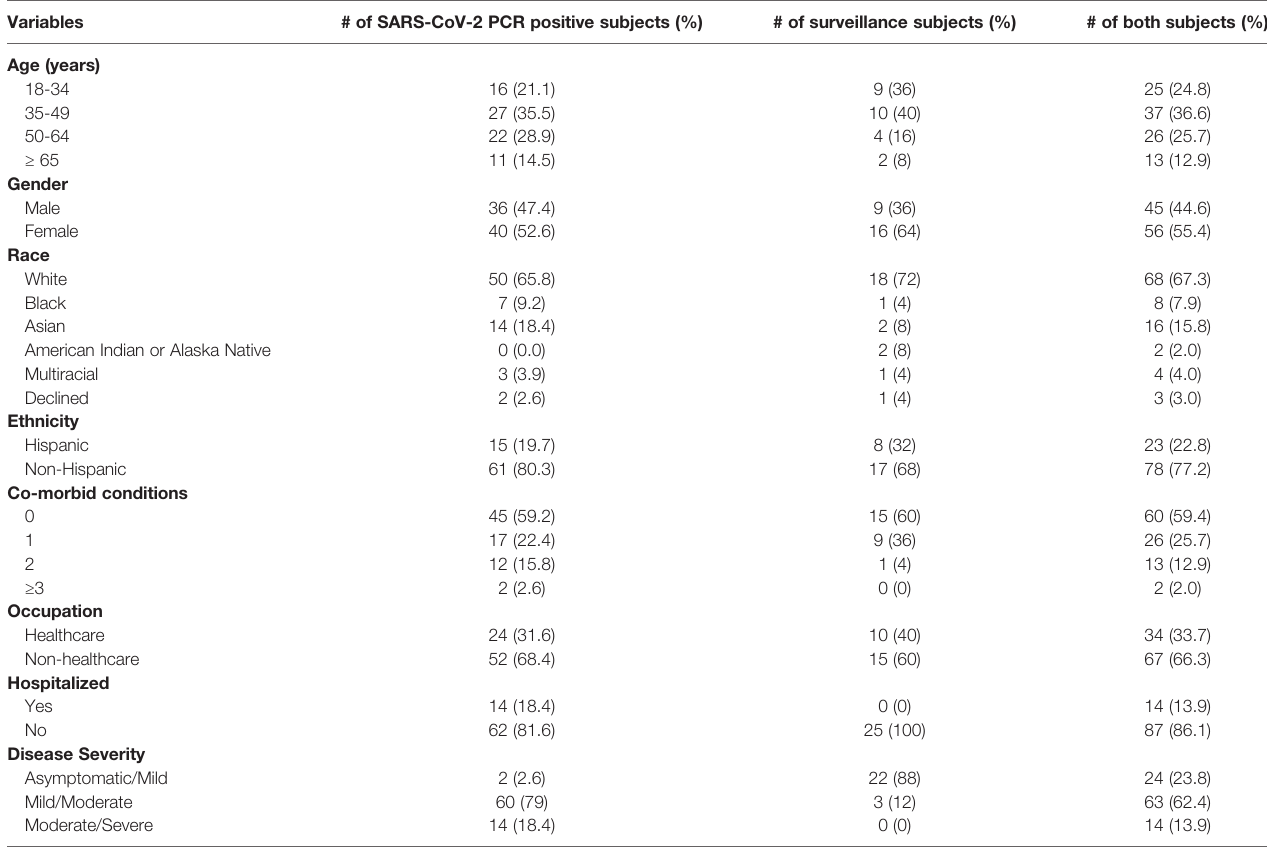
TABLE 3 | Demographic data of the subjects during SARS-CoV-2